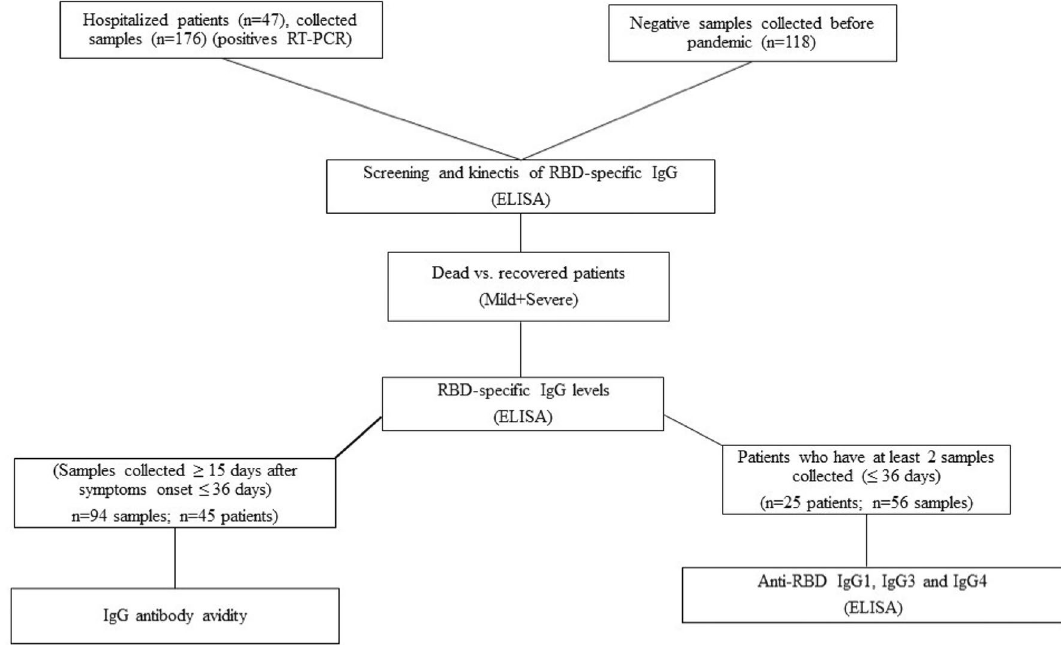
Figure 5. Flow chart representative of the proposed study